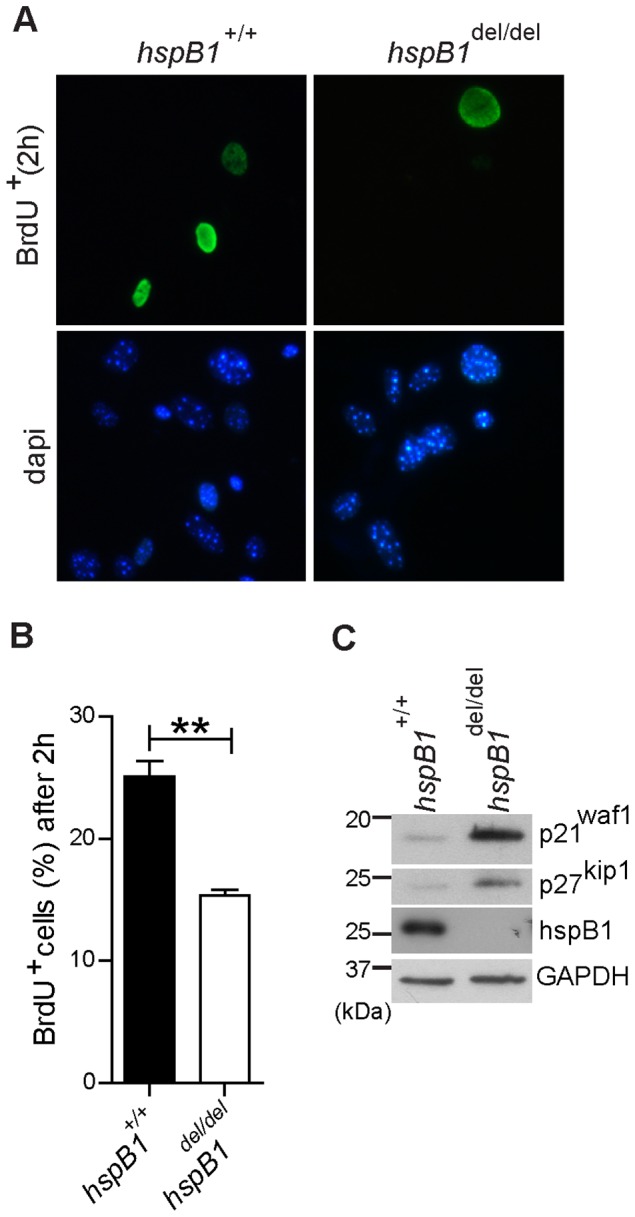
HspB1 deficiency inhibits entry into S phase and increases the expression of p21waf1 and p27 kip1.A, BrdU incorporation following a 2-positive cells (mean % ± SEM) from three independent experiments performed; **P<0.01. C, Western blot of asynchronous MEF lysates for p21waf1, p27kip1, hspB1 and GAPDH as a loading control with molecular weights (kDa) of markers indicated. Western blots are representative of three independent experiments.